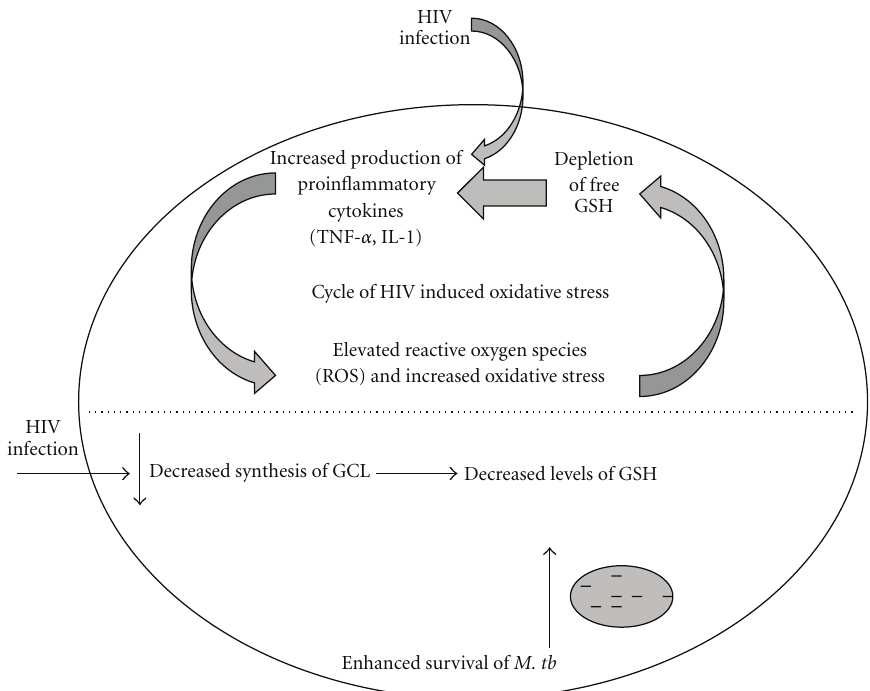
Figure 6: Model illustrating the reasons for decreased levels of GSH in macrophages from individuals with HIV